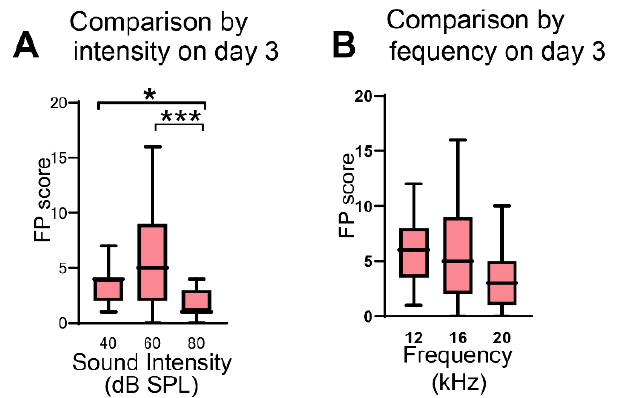
Figure 2. Verification of the sound intensity and frequency in salicylate-treated rats. ( A ) Comparison of FP scores at 16 kHz in three groups conditioned with sound pressures of 40 dB ( n = 19), 60 dB ( n = 31), and 80 dB ( n = 12). The FP scores at 40 dB and 60 dB were significantly higher than those at 80 dB (* p = 0.049 in 40 dB vs. 80 dB, *** p = 0.0003 in 60 dB vs. 80 dB, Kruskal–Wallis test and Dunn’s test). ( B ) Comparison of FP scores at 60 dB in three groups conditioned with sound frequencies of 12 kHz ( n = 17), 16 kHz ( n = 31), and 20 kHz ( n = 17). No significant difference was observed